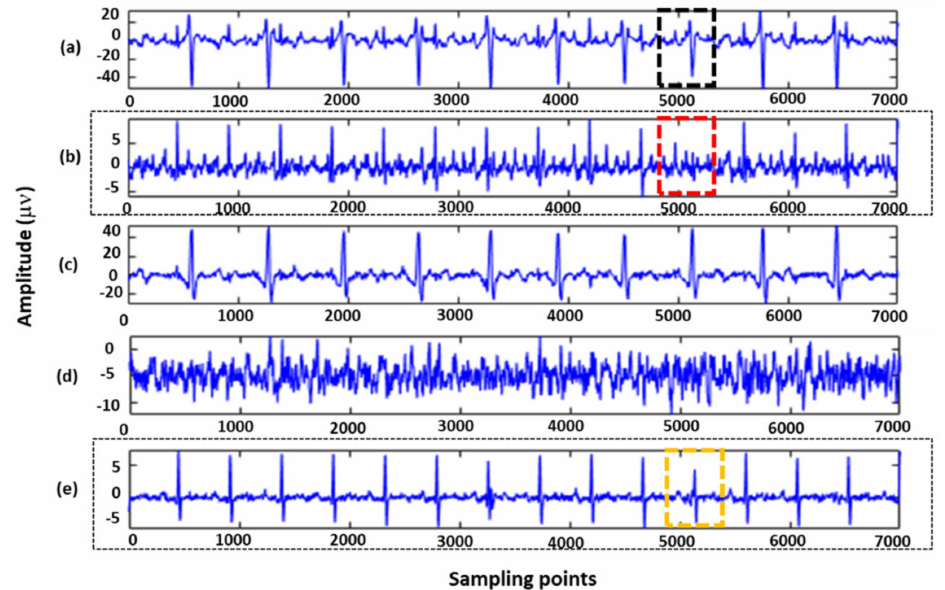
Figure 3. A total of 7000 sampling points of R01 data in the ADFECGDB database were applied to